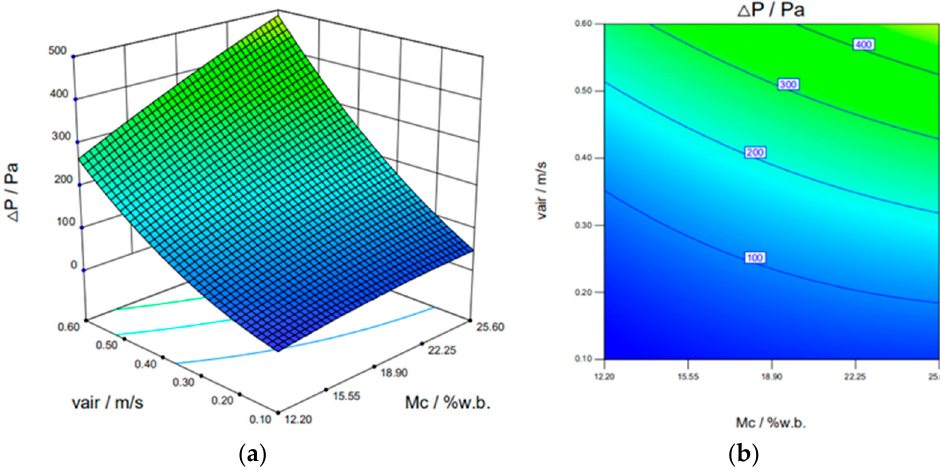
Figure 4. The interaction of Mc and v air on the Δ p ( a ) and the contour plots ( b ).